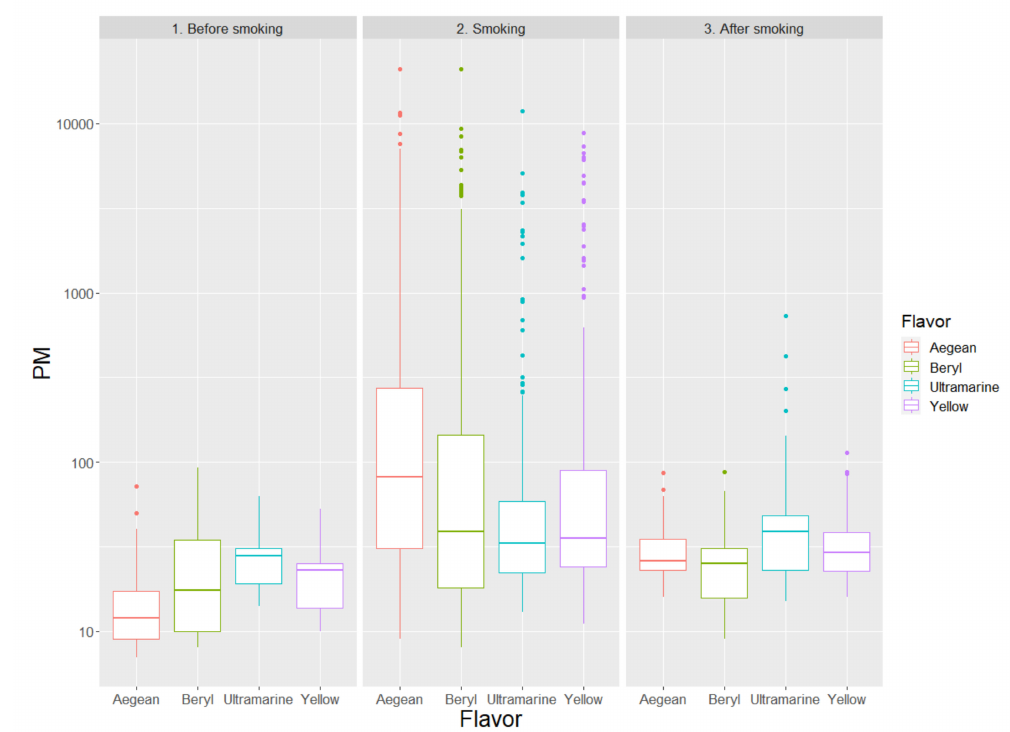
Figure 2. Levels of total particulate matter (PM), expressed as µ g / m 3 , comparing di ff erent flavors of Glo, distinguishing the following phases: before smoking (1), smoking (2), and after smoking (3).